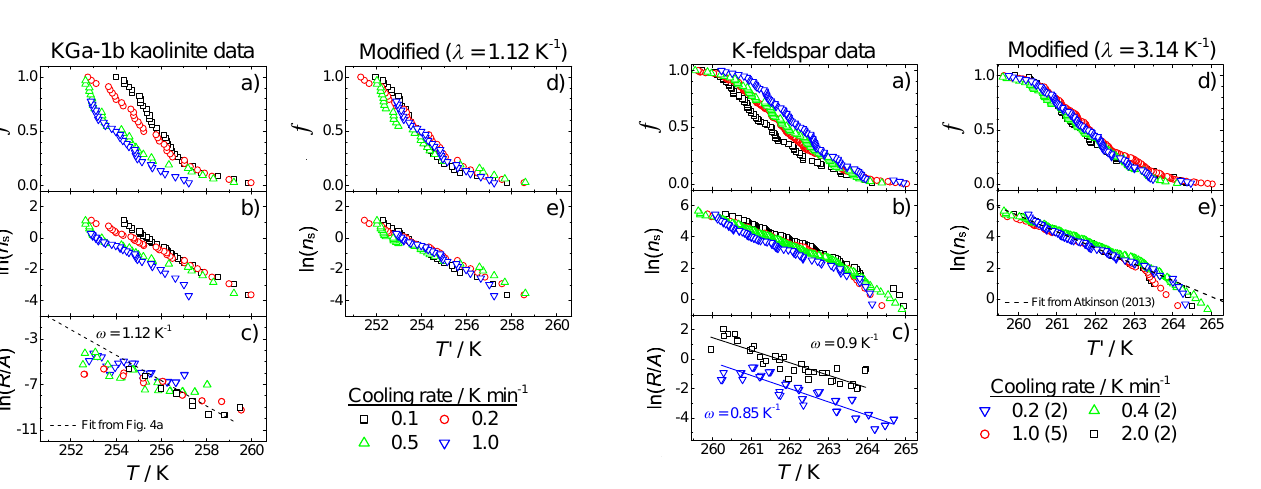
Figure 5. The freezing of droplets containing kaolinite (KGa-1b) in cooling experiments (MICROLITRE). (a) Raw f (T ) data, (b) de- rived R/A(T ) , (c) n s (T ) values, (d) the corresponding normalised f (T 0 ) data, and (e) normalised n s (T 0 ) . Data were normalised us- ing the value of λ determined directly from the linear fit to ln( R/A ) against T in Fig. 4a and reproduced in (c) . Temperature and R/A uncertainty is as in Fig. 4. Uncertainty in n s (not shown) is estimated as ± 20%.